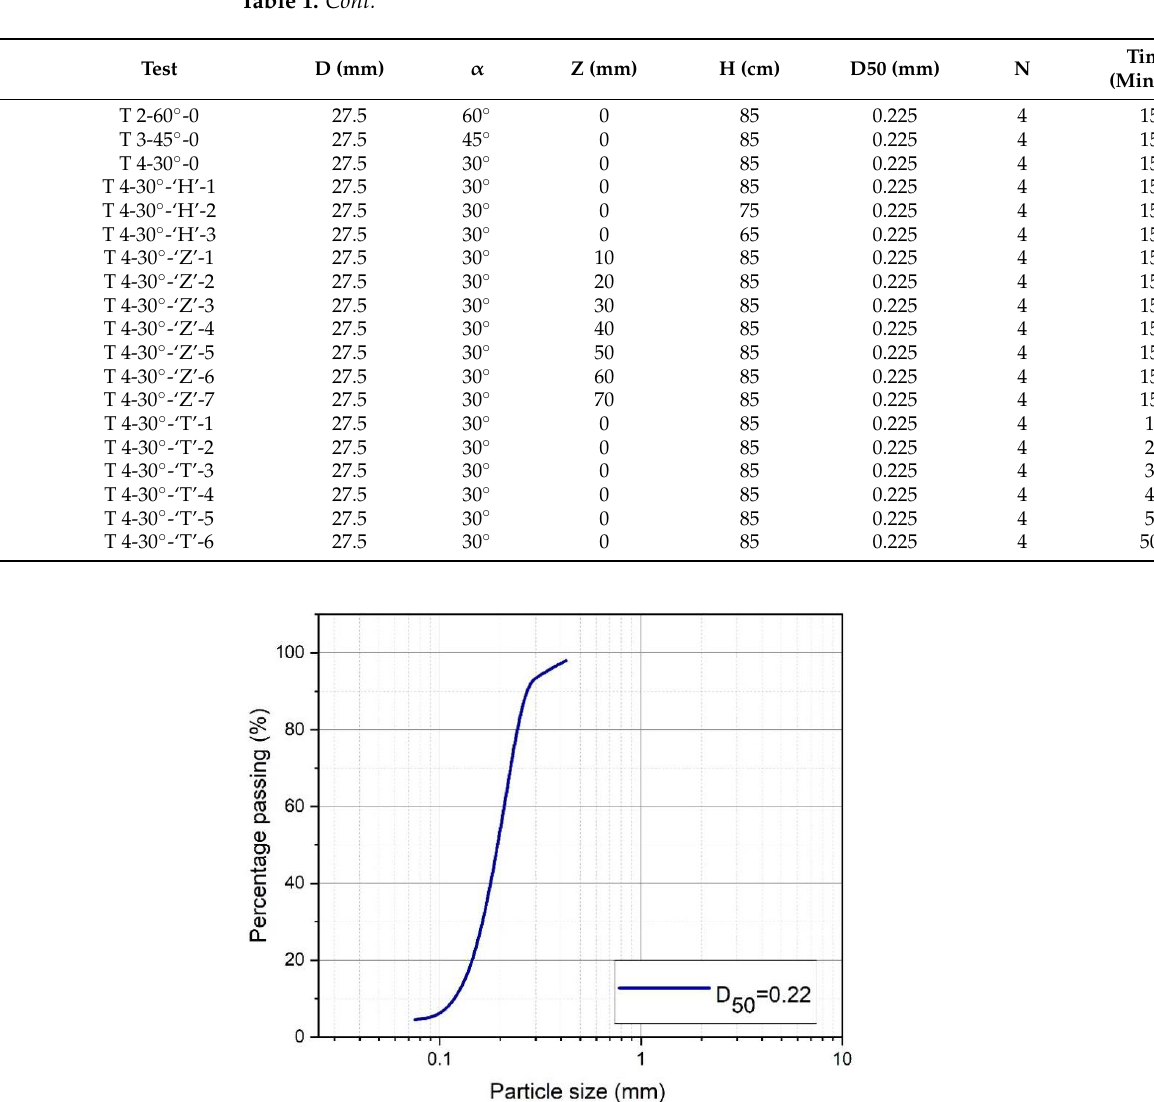
Figure 4. The sediment particle size distribution. Table 1. Geometric characteristics of the experimental test conditions. Three parameters for the HSSR system and four parameters for the FBHSSR system were analyzed in this study. The studied parameters include the effective head (H), the height of the suction pipe from the sand surface layer (Z), and the test period (T). These parameters were applied for both the HSSR and FBHSSR systems. The tests of the FBHSSR model included an additional parameter, the fan blade angles (α), as shown in Figure 5.